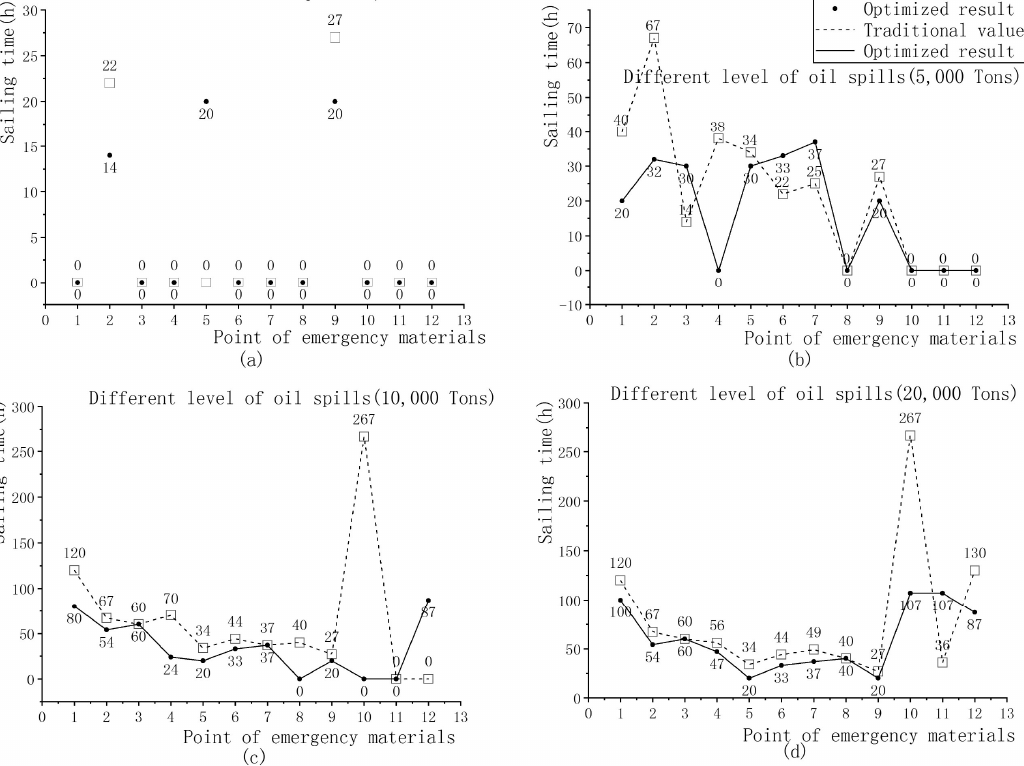
Figure 3. Traditional method compared with the optimization results for di ff erent oil spills in